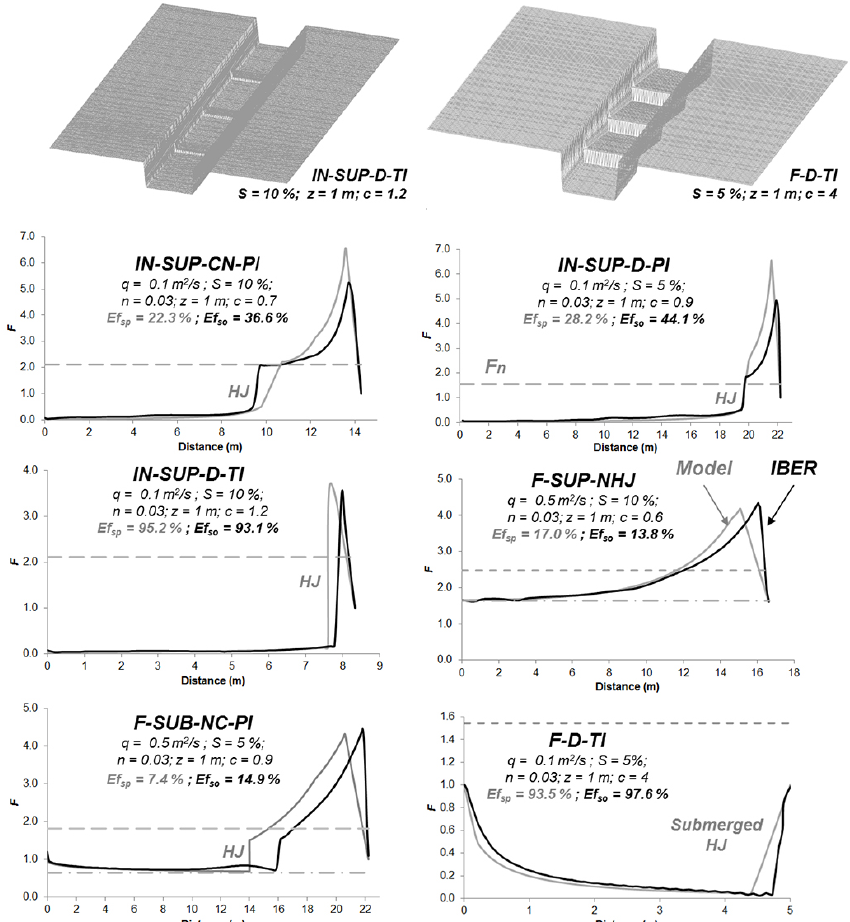
Fig. 5. Input geometry examples in IBER and comparison of Froude number F curves between the model (grey) and IBER (black) for different flow regime typologies as a function of the distance from the downstream check dam. The grey dashed line corresponds to normal conditions and the dashed-dotted line to modified normal conditions for a dam-filling scenario. c represents the steepness factor; D the check dam influence; Ef so the check dam efficiency predicted in IBER; Ef sp the check dam efficiency predicted by the conceptual model; F the dam-filling conditions; IN the initial conditions; NC the normal conditions influence; n the Manning roughness coefficient; NHJ the no hydraulic jump; PI the partial influence; q the unitary discharge; SUB the subcritical normal conditions; S the gully slope; SUP the supercritical normal conditions; TI the total influence; and z the effective check dam